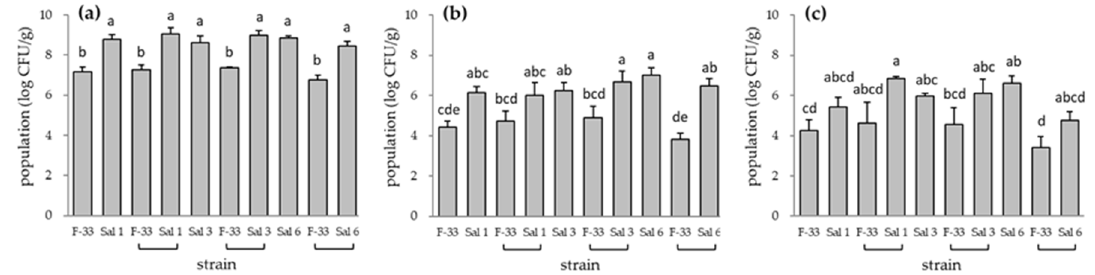
Figure 4. The effect of the seed-co-inoculated Bacillus sp. F-33 with the other endophytic strains, Klebsiella sp. Sal 1, Enterobacter sp. Sal 3, and Herbaspirillum sp. Sal 6, on colonization in the rhizosphere ( a ), root ( b ), and shoot ( c ) of the tomato plant. The tomato plant was cultivated using sterilized vermiculite, and colonization was examined at 14 days after seed-co-inoculation. The bracket on the x-axis indicates each population in co-inoculation, and no bracket indicates single inoculation. No colony appeared in the control samples. The bars represent the standard deviation (n = 4), and different letters indicate significant differences at p < 0.05 by Tukey’s test.